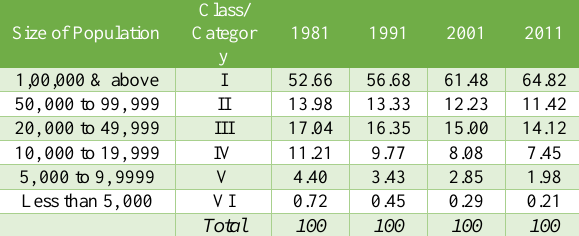
Table 4. Population Growth among the Six-fold Classification of Towns and Cities in India: 1981 to